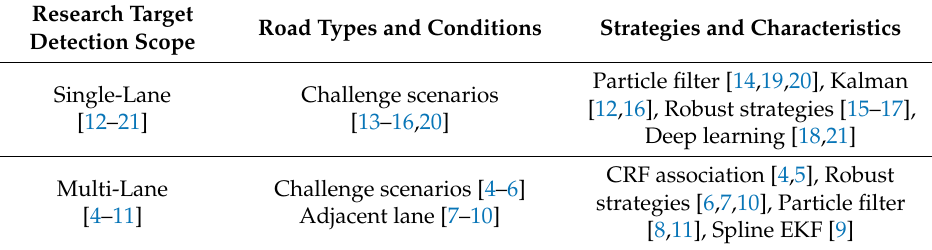
Table 1. Various approaches for lane detection.